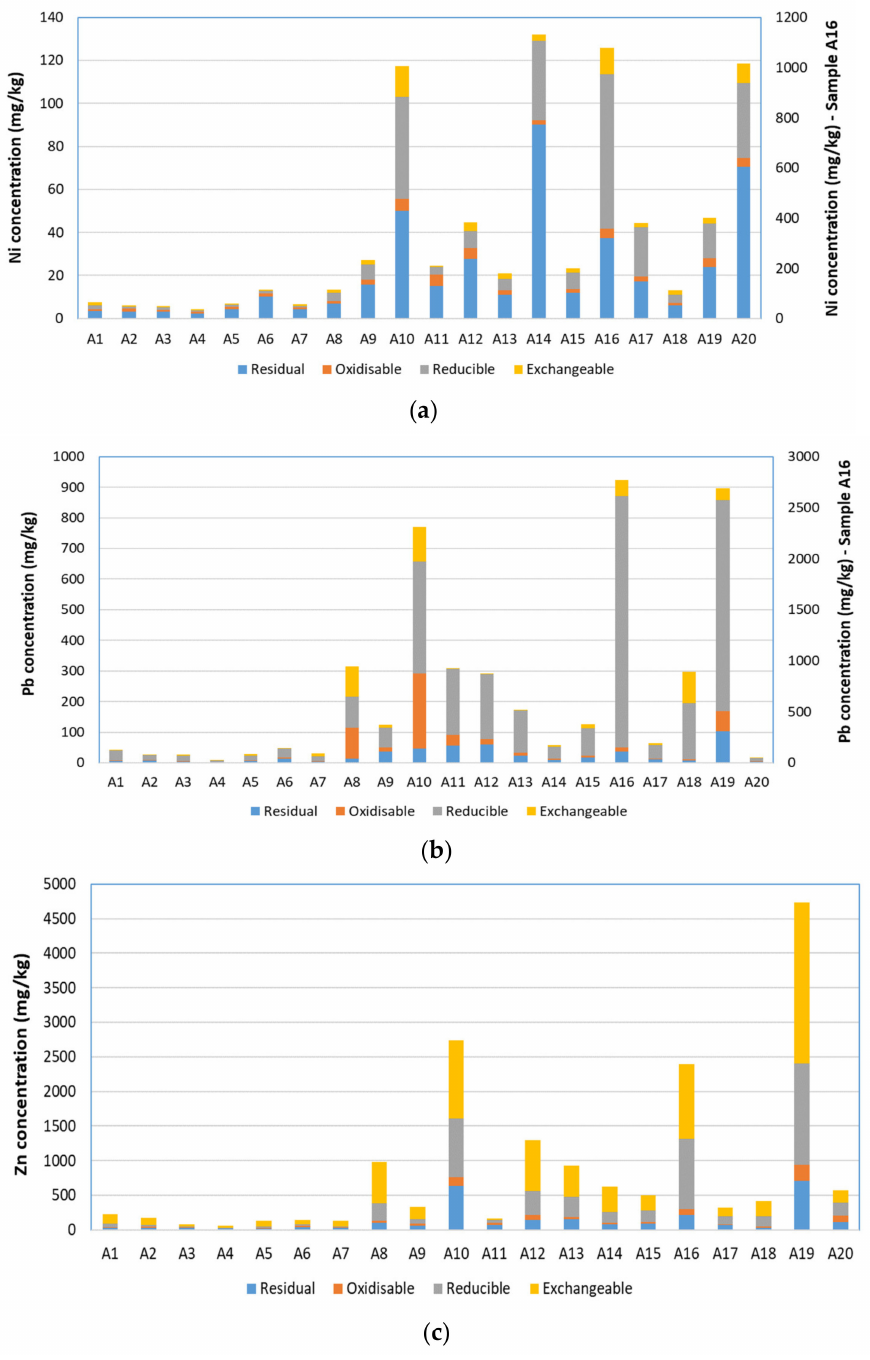
Figure 3. Fractionation of ( a ) Ni, ( b ) Pb and ( c ) Zn according to BCR sequential extraction. Note that Ni and Pb are plotted against a secondary axis for site